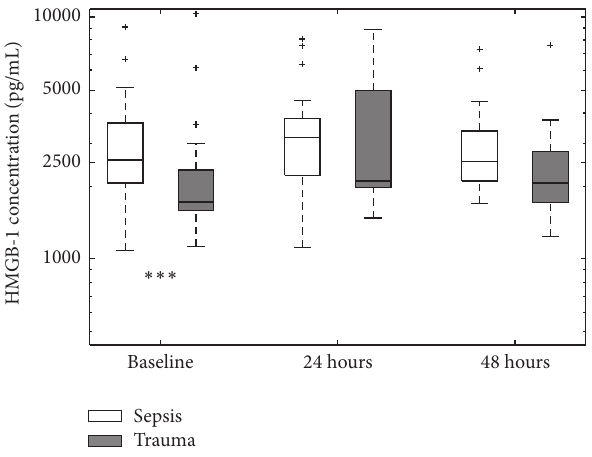
Figure 4: Plasma HMGB-1 levels in contrasting sepsis ( 𝑛 = 24 ) and trauma ( 𝑛 = 20 ) groups. “ ∗ ∗ ∗ ” indicates significant ( 𝑝 < 0.05 ) difference in plasma HMGB-1 median concentration between groups at a particular time point. Outliers were plotted separately and indicated by